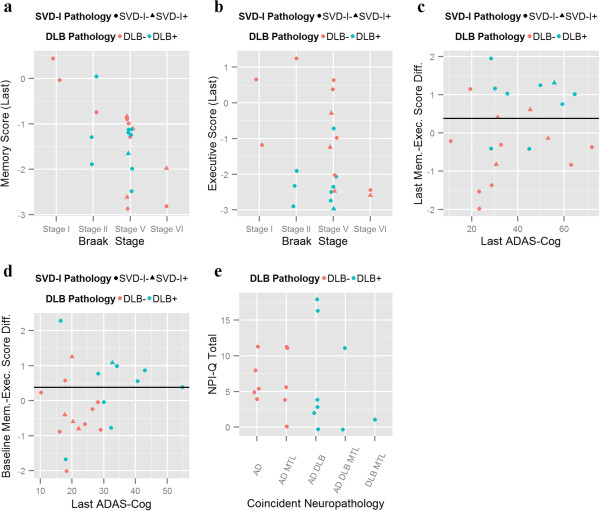
Clinical correlates. a) Memory and b) Executive summary composites in subjects stratified by Braak stage and presence of coincident DLB and SVD-I. c) Last and d) Baseline visit executive-memory mismatch based on the absence or presence of coincident DLB and/or SVD-I. e) NPI-Q total score based on neuropatholgically defined groups.